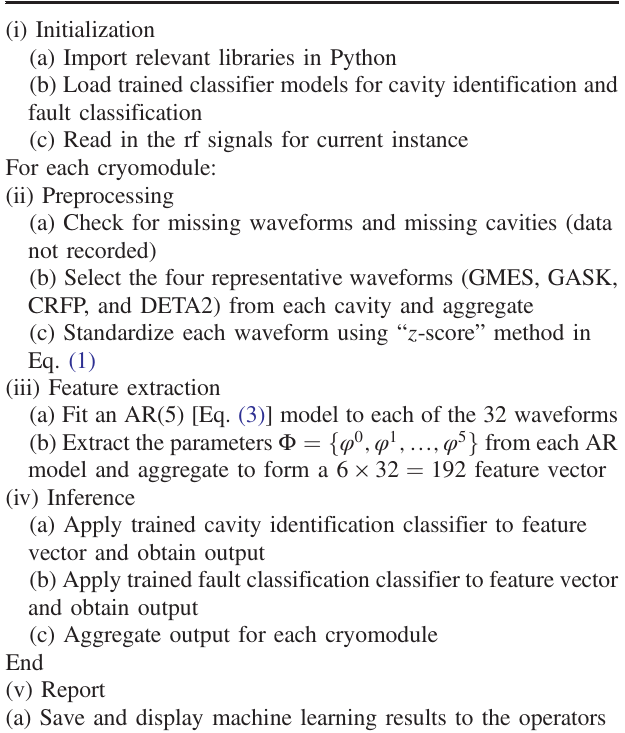
Algorithm 1. Machine learning for online cavity and fault recognition.